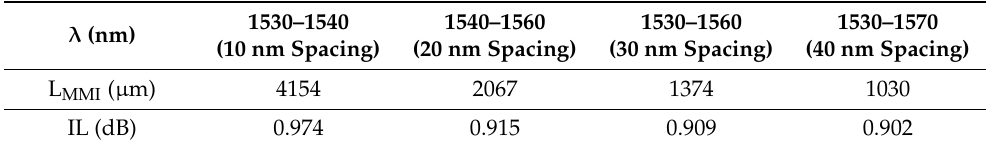
Table 2. Coupling length behavior for different wavelength spacing channels.